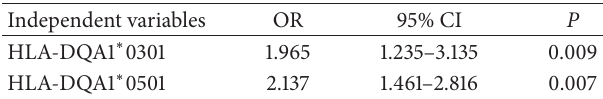
Table 4: Logistic regression analysis of association between T2DM and HLA alleles.